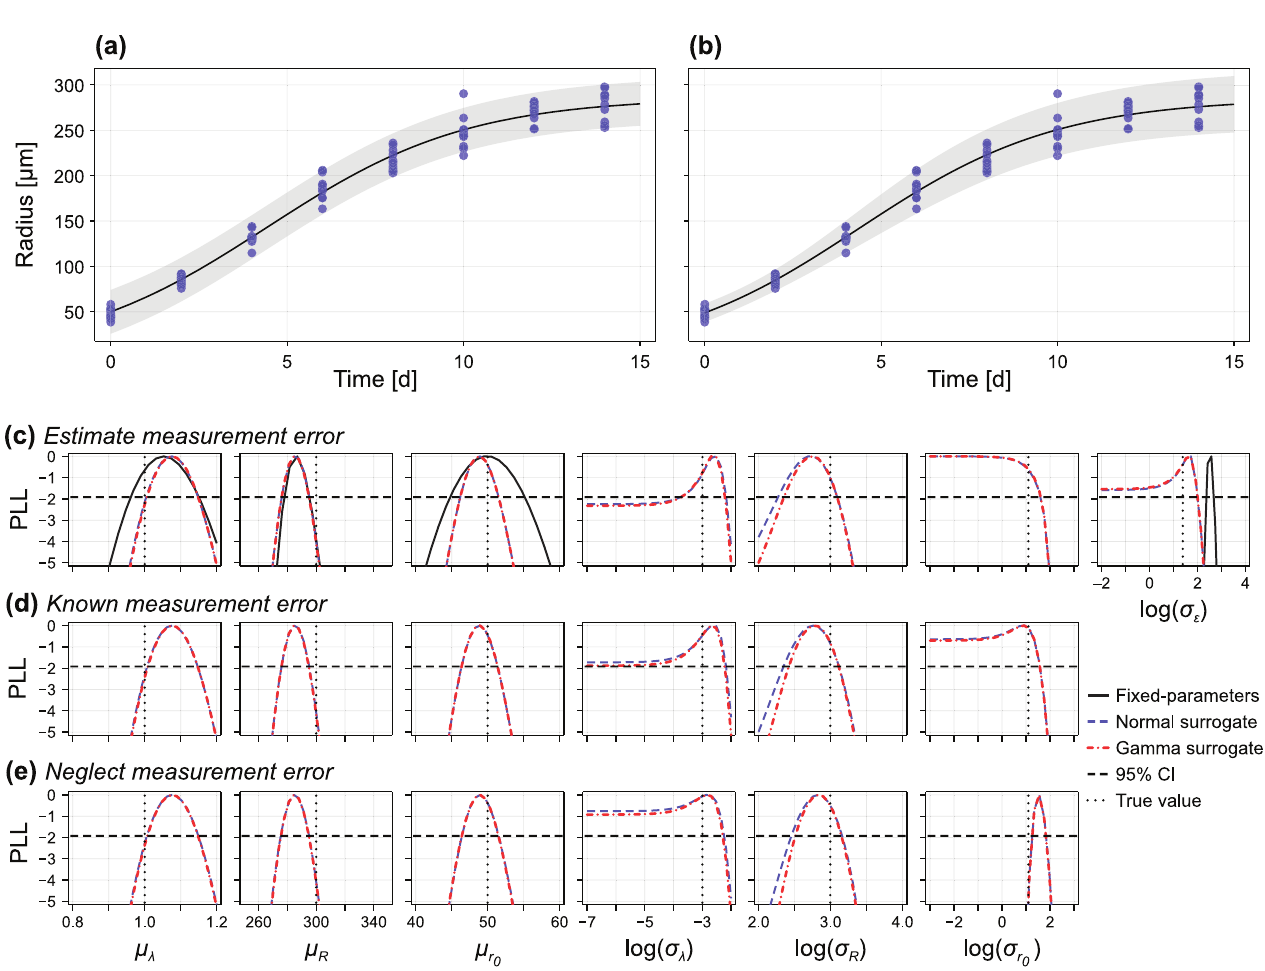
Fig 3. Profile likelihood analysis for logistic model with random parameters. We perform inference on a synthetic data set comprising N = 10 measurements at t = 0, 2, 4, ... , 14 of the random parameter logistic model (i.e., 80 independent measurements). In (C) we treat the standard deviation of the measurement noise, σ ε as unknown, in (D) we assume σ ε is known (for example, pre-estimated), and in (E) we work with a misspecified model where we assume σ ε = 0, corresponding to a scenario where we assume all variability in the data is due to variability in mechanistic parameters. In (C–E) we compare profiles produced using a normal surrogate model (blue dashed) and gamma surrogate model (red dotted). In (C) we also take a standard inference approach, assuming that observations are normally distributed about model predictions and where parameter variability is neglected (the fixed parameter model). In (A, B) we show the data (blue), model mean (black) and 95% prediction interval at the MLE using (A) the fixed parameter model, and (B) the random parameter approach with a gamma surrogate. Also shown are the true parameter values (black vertical dotted) and a 95% confidence interval threshold (black horizontal